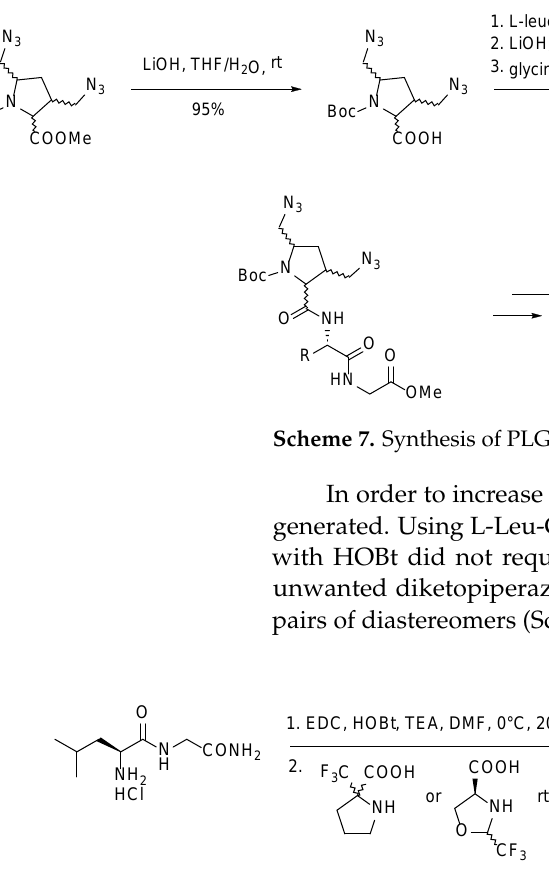
Scheme 8. Synthesis of fluorinated analogues of PLG.